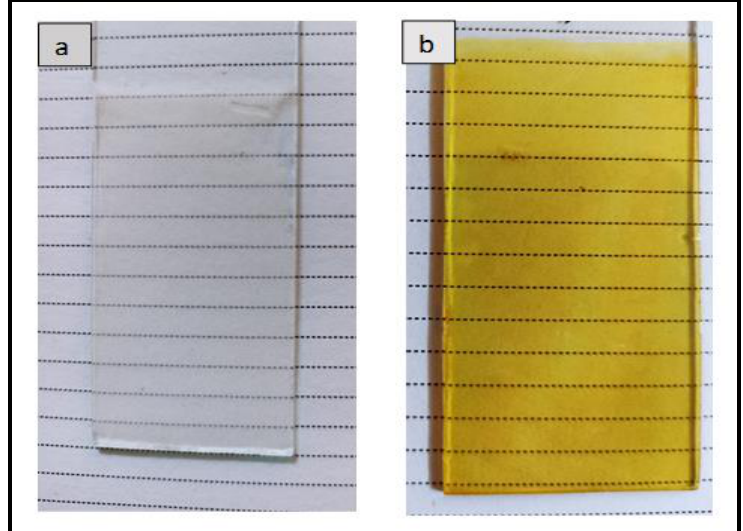
Figure 3. The photography images of thin films: ( a ) before, and ( b ) after the annealing process. Thin film thickness ( d ) was measured using the optical interferometer